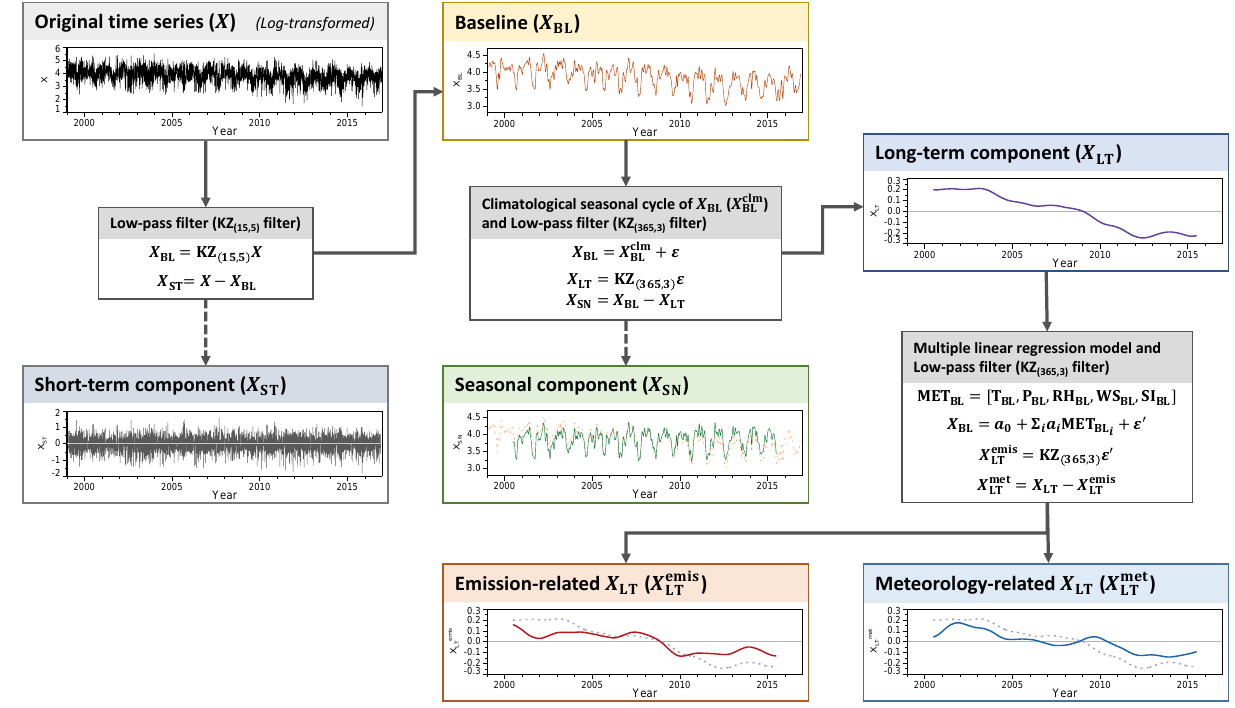
Figure 2. Schematic flowchart of temporal decomposition of air pollution time series (Seoul average daily PM 10 concentration) into short- term, seasonal, and emission-related and meteorology-related long-term